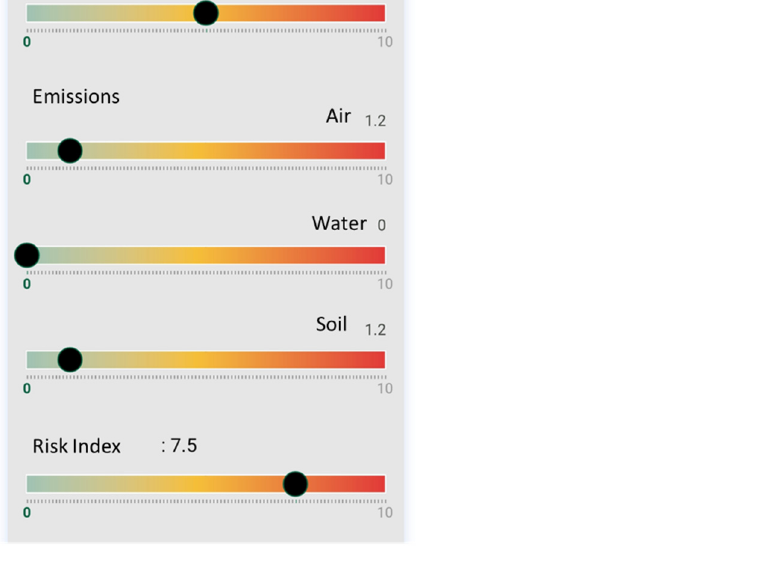
Figure 9. Excerpt from the report generated with the NanoSerpa v1.0 app for a leak of black carbon from a pneumatic transport pipe.